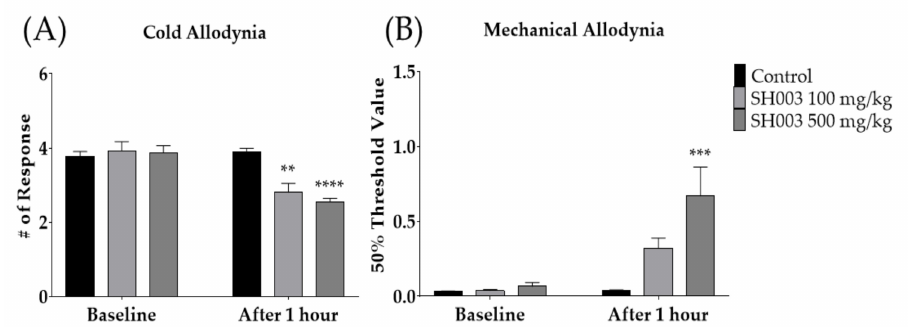
Figure 3. Effect of SH003 oral administration on cold and mechanical allodynia induced by multiple paclitaxel injection in mice ( A , B ). Behavioral measurements were conducted before (baseline)